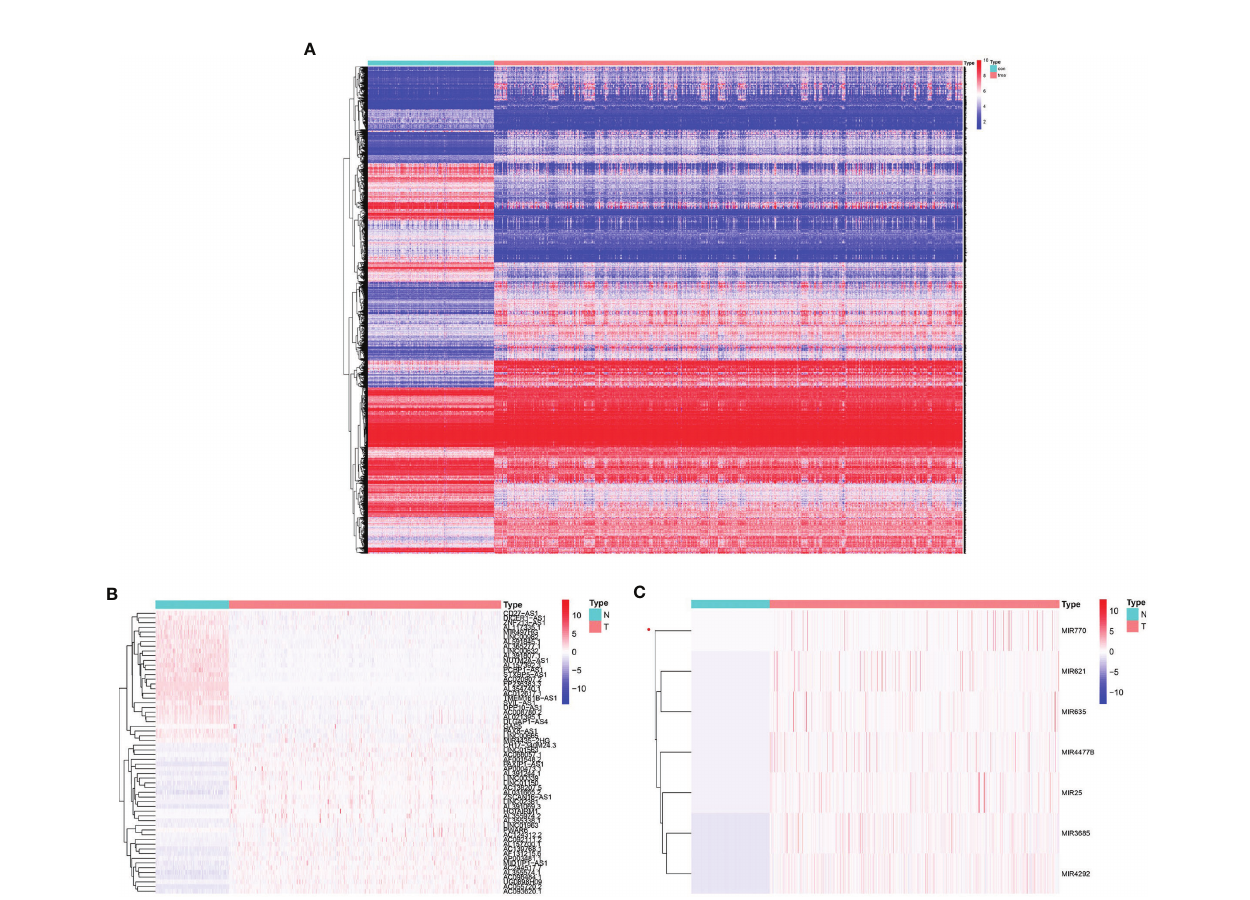
FIGURE 1 | Heatmap with prognostic differentially expressed genes (DEGs). (A) DE prognostic mRNAs. (B) DE prognostic long noncoding RNAs (lncRNAs). (C) DE prognostic